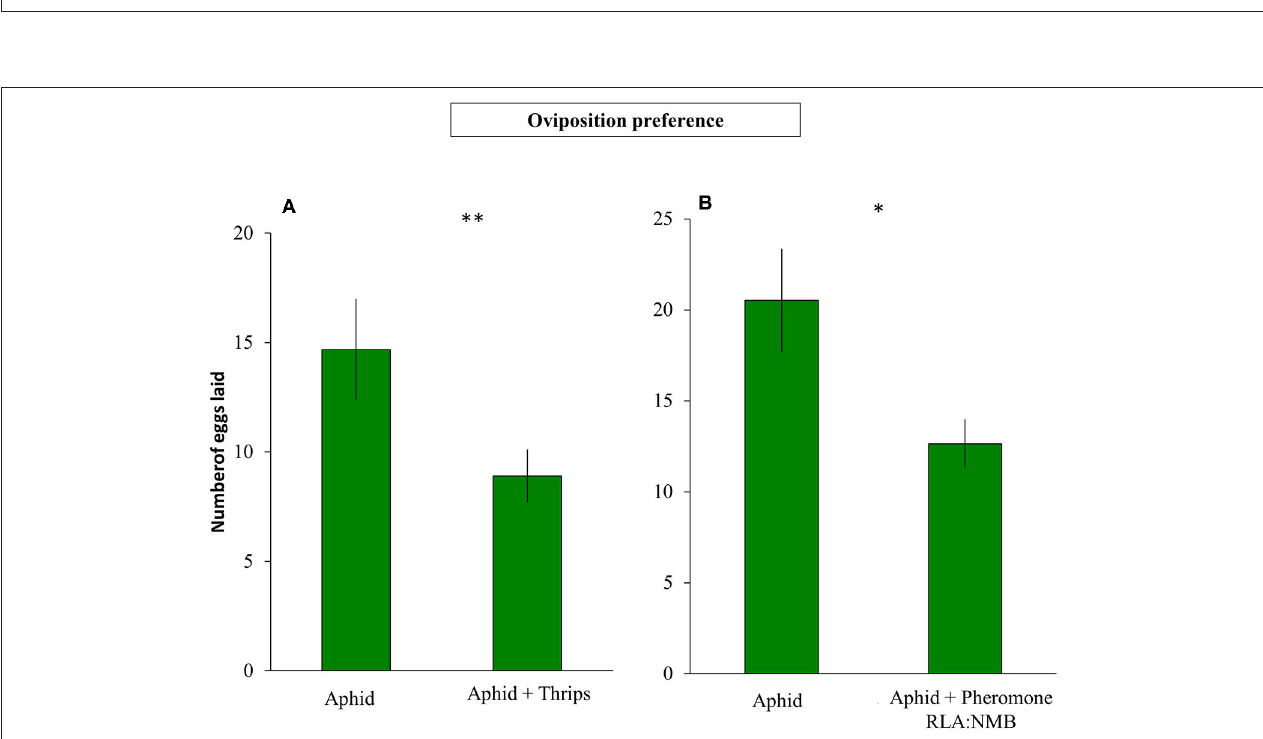
FIGURE 4 | Oviposition of S. rueppellii on sweet pepper plants after 24h (A) Number of syrphid eggs laid on aphid vs. aphid + thrips-infested plants ( n = 60 replicates) and (B) number of syrphid eggs laid on aphid-infested plants vs. aphid-infested plants plus 2 µ l of 1 RLA: 2.3NMB F. occidentalis aggregation pheromone ( n = 42 replicates). Bars represent means ± SE. Asterisks indicate significant differences between infestation treatments: ** P ≤ 0.001, * P < 0.05 (Wilcoxon test).